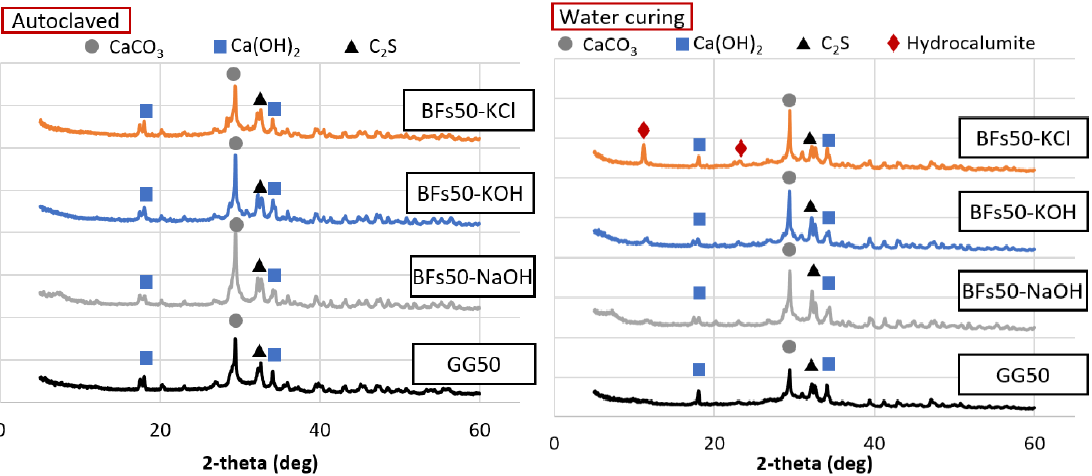
Figure 7. Mineral analysis of the 50% BFS and 50% OPC mortar samples with KCl separated from CBD, NaOH, and KOH as activators.